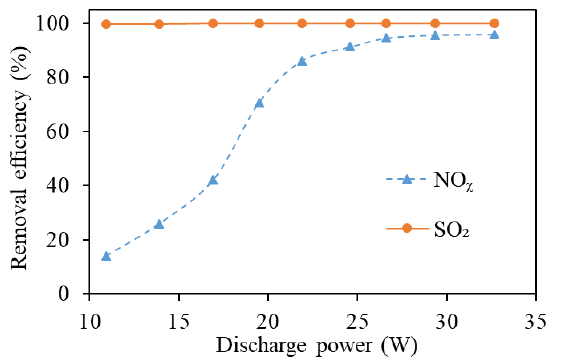
Figure 9. Effects of discharge power on desulfurization and denitration efficiency levels (operating conditions: gas flow rate = 5 L/min, scrubbing solution = 1% NaOH solution, spray density = 7.6 m 3 /(m 2 · h), packing type = D g 6 mm Dixon ring, packing height = 80